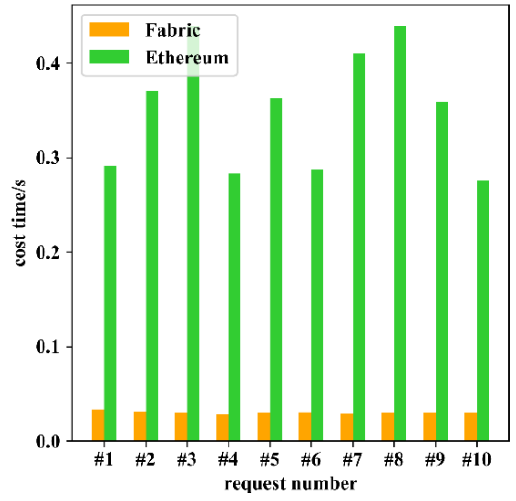
Figure 8. Time cost of processing a single access control request.